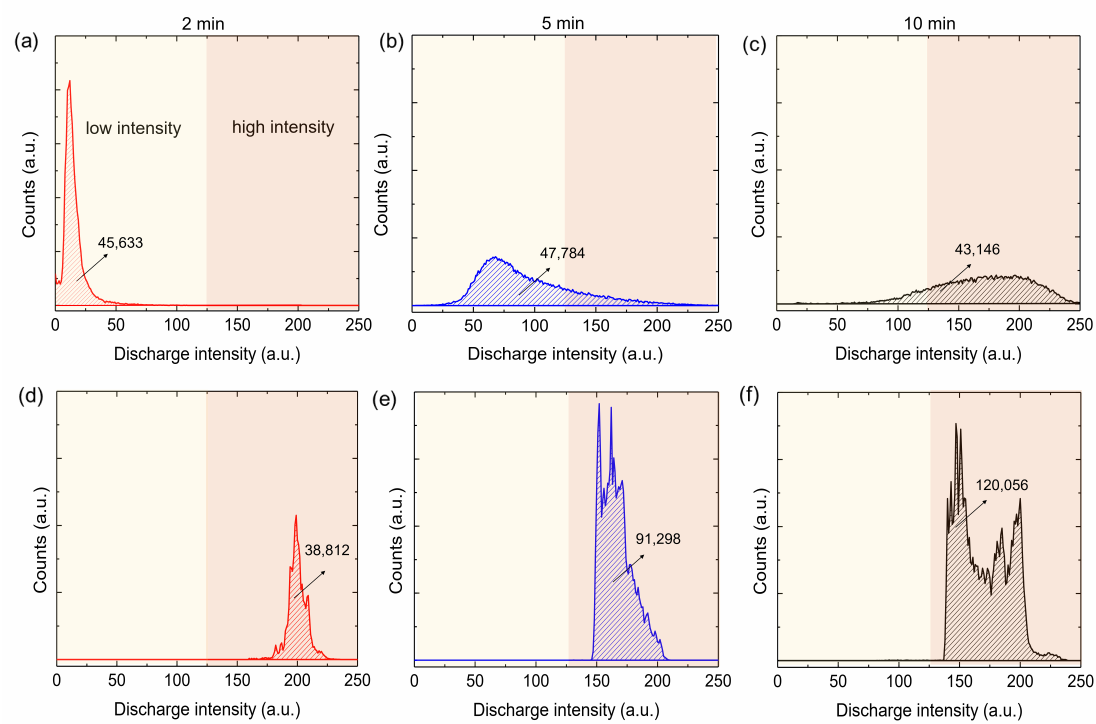
Figure 2. Curves showing the fraction and intensity of plasma discharges during PEO in ( a – c ) bath A and ( d – f ) bath